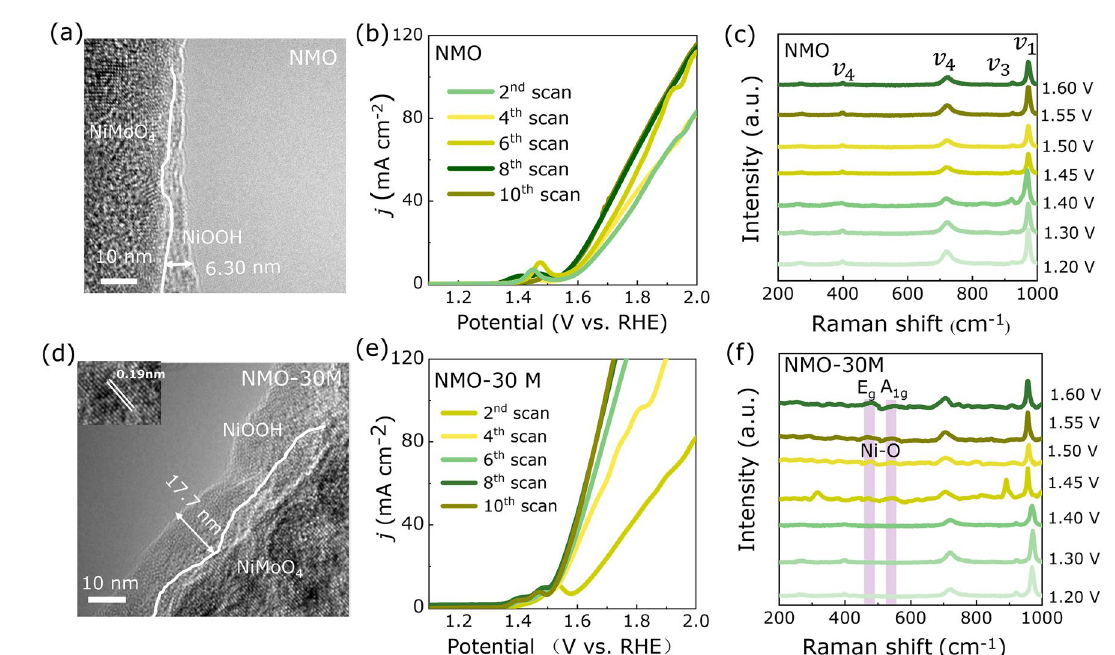
Fig. 5 Self-reconstruction of NMO and NMO-30M in 1 M KOH during OER. The morphology structures of a NMO and d NMO-30M after self-reconstruction. The self-reconstruction process of b NMO and e NMO-30M. In situ Raman spectra of c NMO and f NMO-30M tested in 1 M KOH at different potentials versus RHE during OER